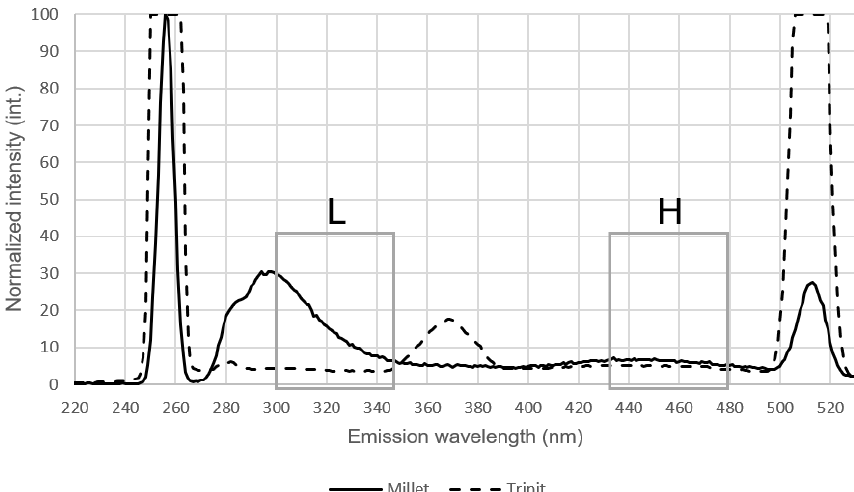
Figure 2. The 2D spectra at excitation wavelength 254nm for two representative samples (Millet on 3 May 2021 and St Trinit on 1 Febru- ary 2021). Comparison with Ohno (2002) H and L